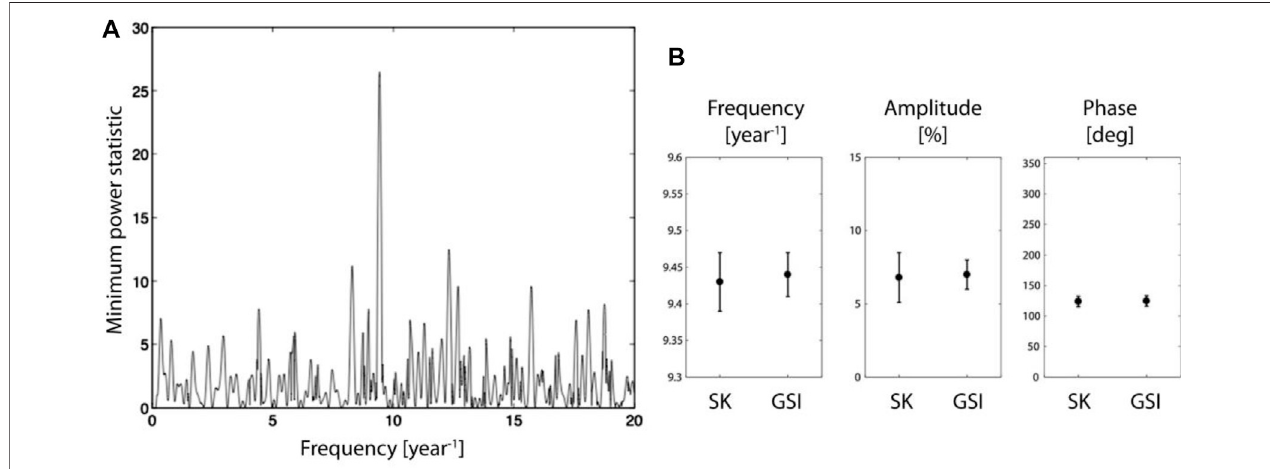
FIGURE 4 | (A) The minimum power statistic formed from the Super-Kamiokande power spectrum and the GSI midnight power spectrum. The most signi fi cant featureisfoundat9.43 year − 1 ,withvalue26.64,whichcouldhaveoccurredbychanceintheband0 – 20 year − 1 fromnormallydistributedrandomnoiseinbothdatasets with a probability of 3 × 10 – 10 . (B) Frequency, amplitude and phase of the 9.43 year − 1 oscillation as it appears in Super-Kamiokande measurements and in GSI measurements. A similar version of this sub fi gure we published already in a previous paper